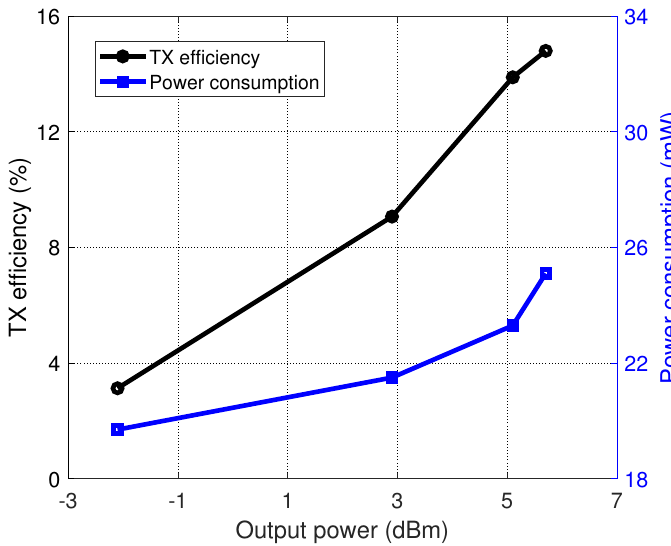
Figure 16. Measured whole TX efficiency. Table 2. Performance summary and